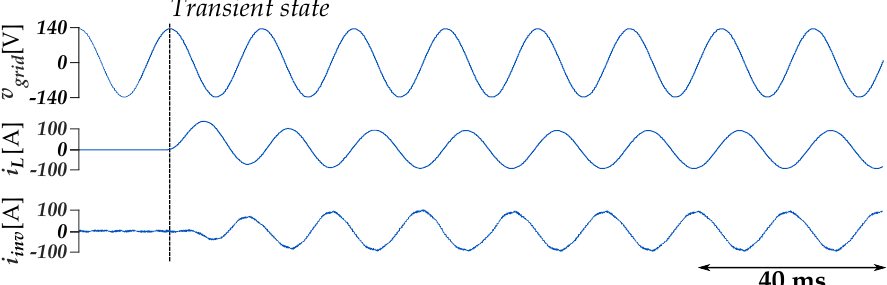
Figure 18. Simulated waveforms confirming the dynamic behavior for inductive load